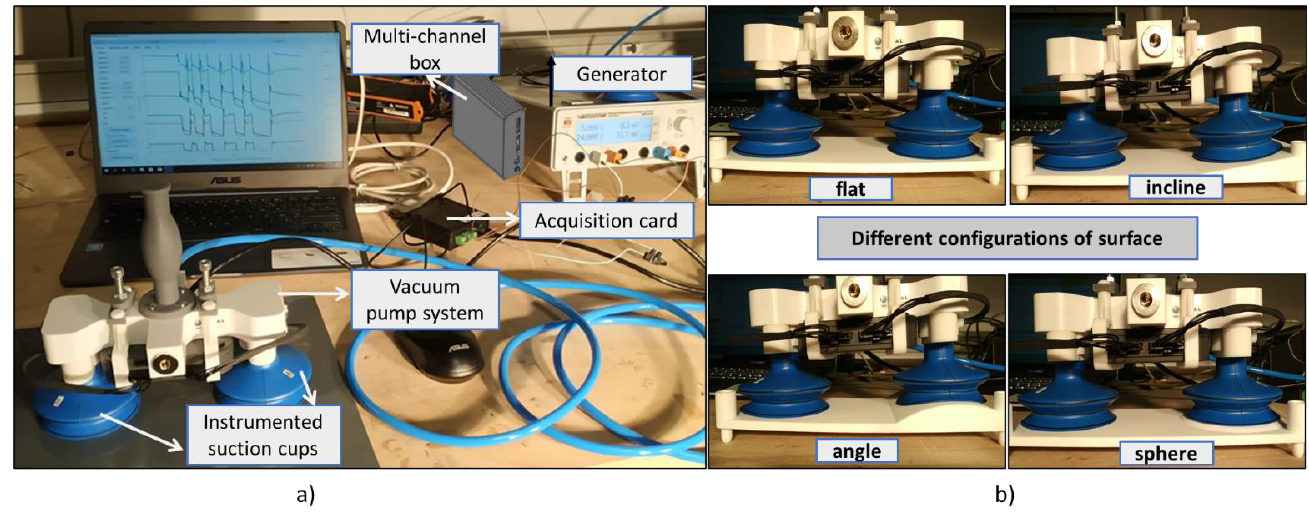
Figure 7. Experimental setup used for piezoresistive characterization of 3D coated suction cups: ( a ) specific test bench with acquisition system; and ( b ) four configurations with flat, inclined, angular, and spherical surfaces.